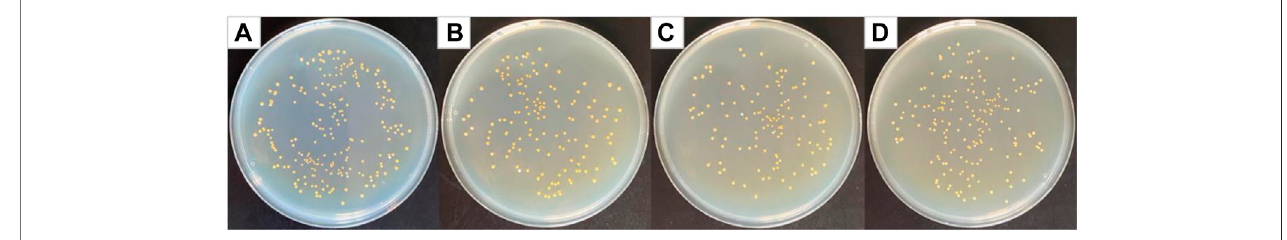
Frontiers in Chemistry |